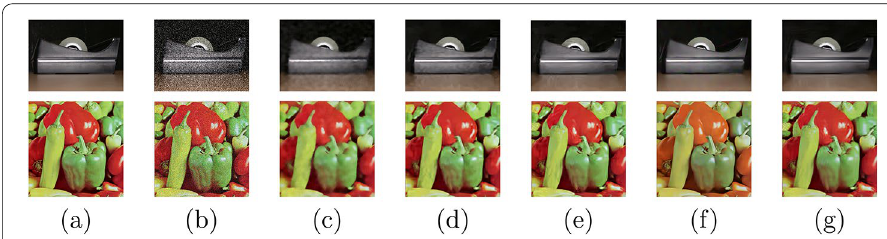
Fig. 11 Denoising results of color images ( tape and Pepper ) with the noise variance σ = 50 . From the left ( a ) to right ( g ) are: the original image, the noisy image, the results obtained by NLM, BM3D, OGLR, ADnet and the proposed method respectively